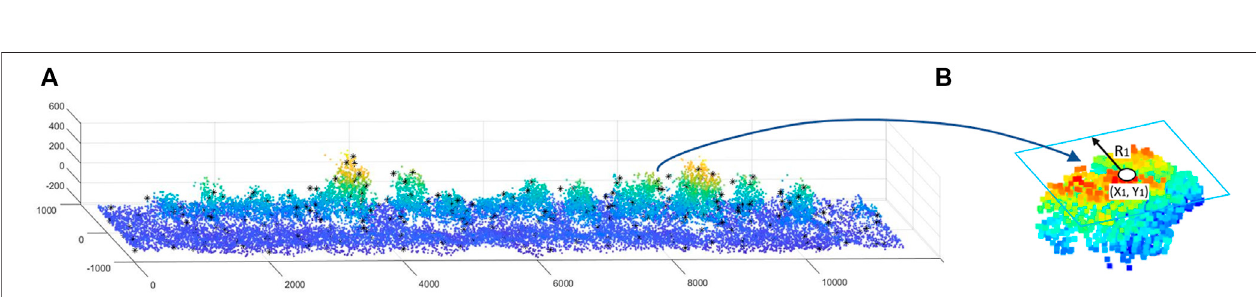
FIGURE 3 | (A) Reconstruction of a cabbage crop row (B) Individual cluster of a cabbage plant.